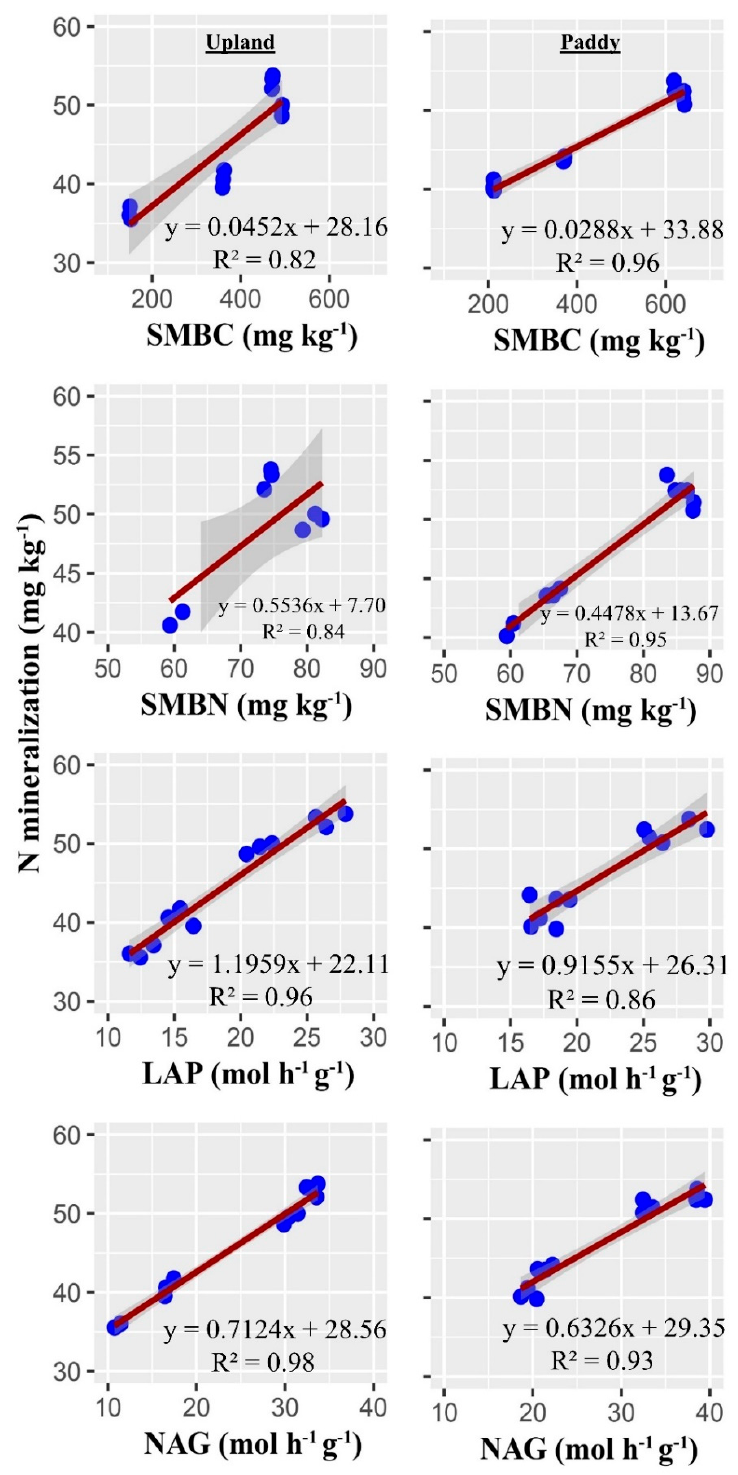
Figure 4. Relationship between net N mineralization and SMBC, SMBN, LAP and NAG under long-term upland and paddy experiment. The shaded area indicates the range at 95% confidence intervals. Permutation p values less than 0.05 and 0.01 were considered significantly different at p < 0.05 and p <